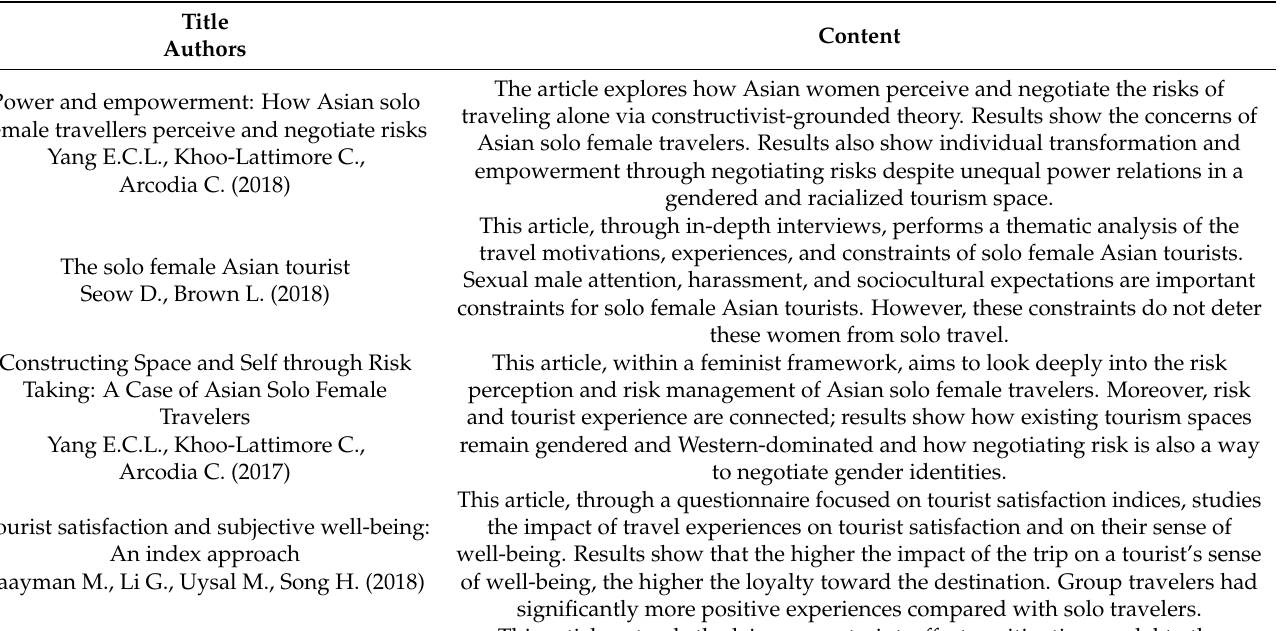
Table 4. Content analysis of the most cited and the most recent publications regarding “Solo Travel” ( n =